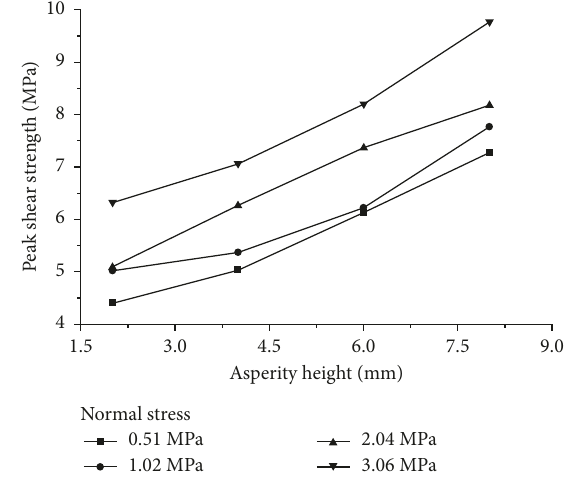
Figure 16: Relationship between peak shear strengths and asperity heights under different normal